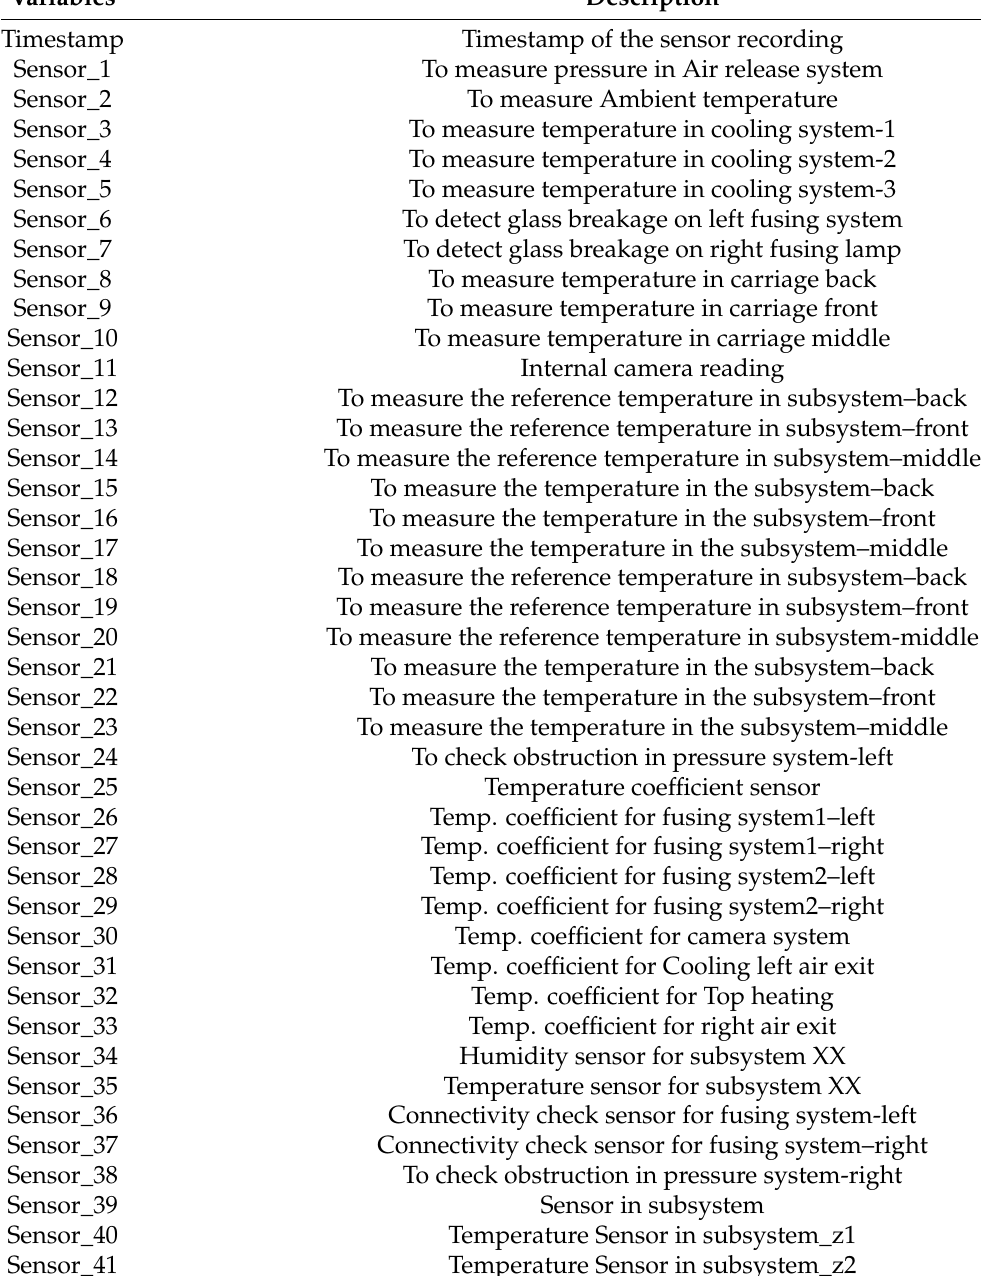
Table 1. List of